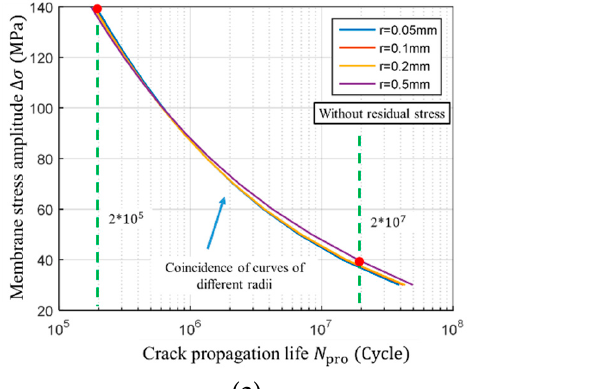
Figure 19. Calculation results of S − N curve at crack propagation stage. ( a ) S − N curve of crack propagation with different notch radius without residual stress; ( b ) S − N curve of crack propagation with different notch radius with residual stress.